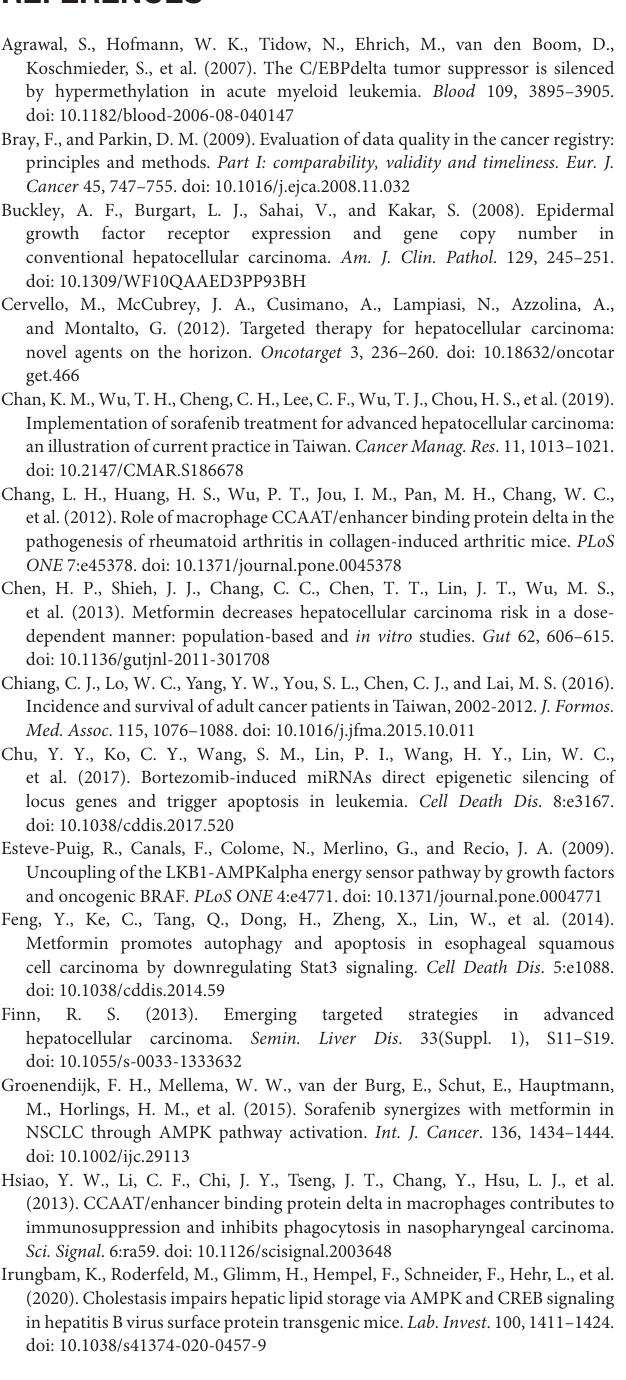
24h and harvested for Western blot analyses. (B) Huh7 cells were pretreated with or without the AMPK inhibitor compound C (10 µ M) for 0.5h and then treated with or without sorafenib (2.5 µ M) for an additional 6h. Whole cell lysates were harvested for Western blot analyses and examined indicated proteins with specific antibodies. Supplementary Table 1 | Animal studies comply with the ARRIVE